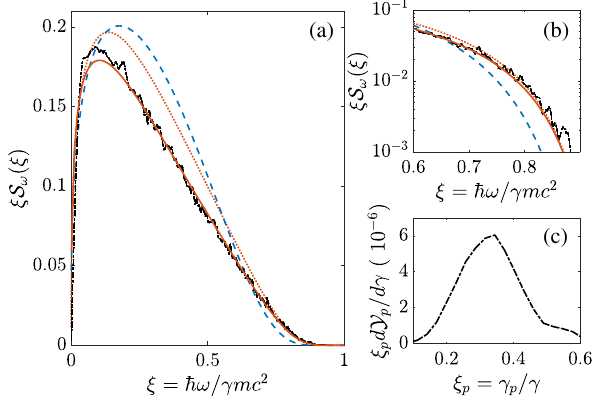
FIG. 2. (a, b) Beamstrahlung energy spectrum, for two colliding beams of N ¼ 5 . 8 × 10 10 particles, E ¼ 30 GeV energy, σ 0 ¼ 1 μ m spot size and σ 3 μ m length. The blue dashed line z ¼ represents the uniform averaged field model [3], the black dot- dashed line represents the OSIRIS simulation, the red solid line is the numerical evaluation of Eq. (4a), and the second red dotted line is the analytical approximation of Eq. (4a) given by Eq. (4b). (c) Energy spectrum of secondary pairs energy from the OSIRIS simulation.